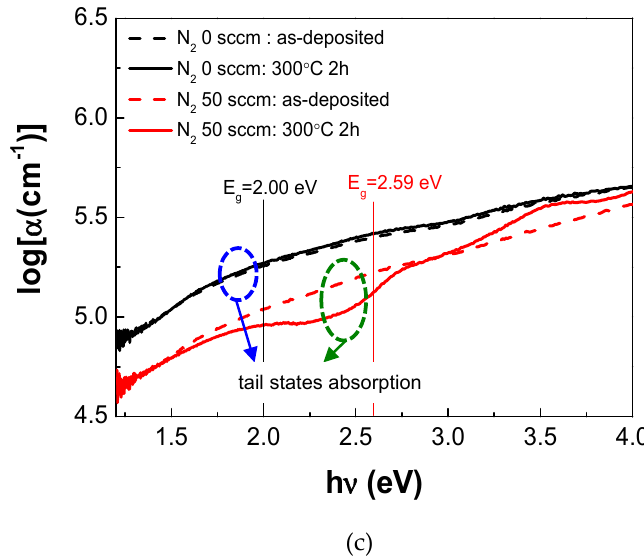
Figure 3. ( a ) Transmittance spectra of as-deposited and post-annealed films grown under N 2 0 and 50 sccm, respectively. ( b ) Optical bandgap with respect to N 2 flow rates using Tauc’s plot. ( c ) The tail state absorption with respect to N 2 flow rates.